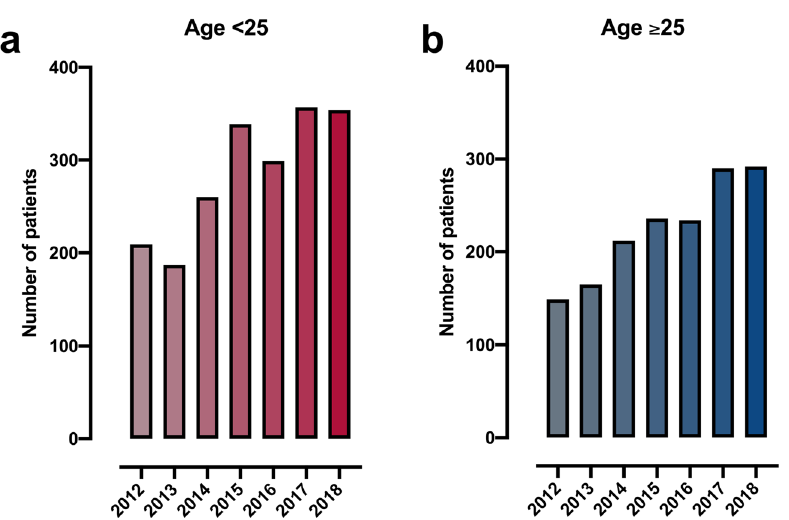
Figure 2. Annual number of stab injuries in young people (age under 25 years, A ) and older people (age 25 years and over, B